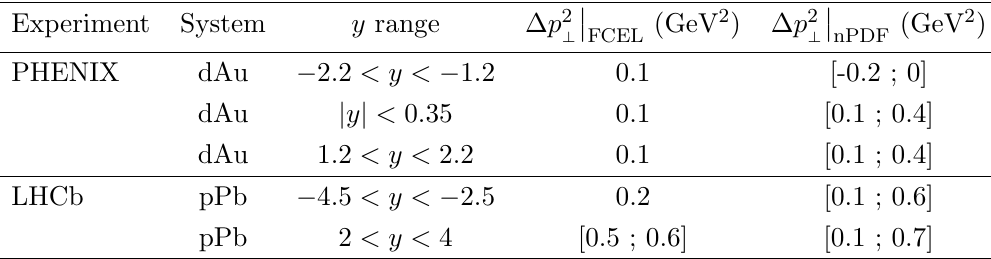
(cid:12) at RHIC and (cid:12) nPDF ?